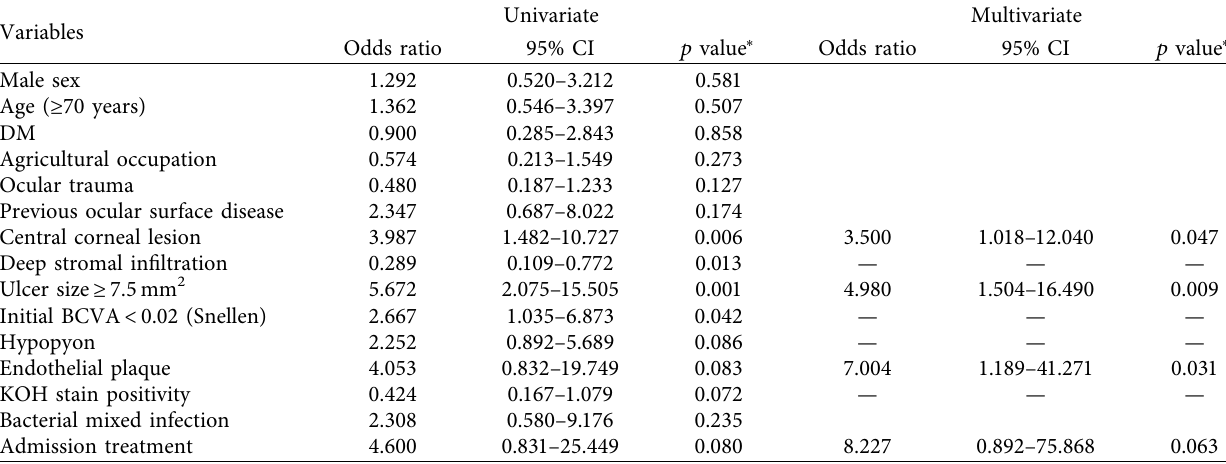
Table 7: Risk factor for poor clinical outcomes in the total cohort of patients with culture-proven Fusarium keratitis (univariate and multivariate logistic regression